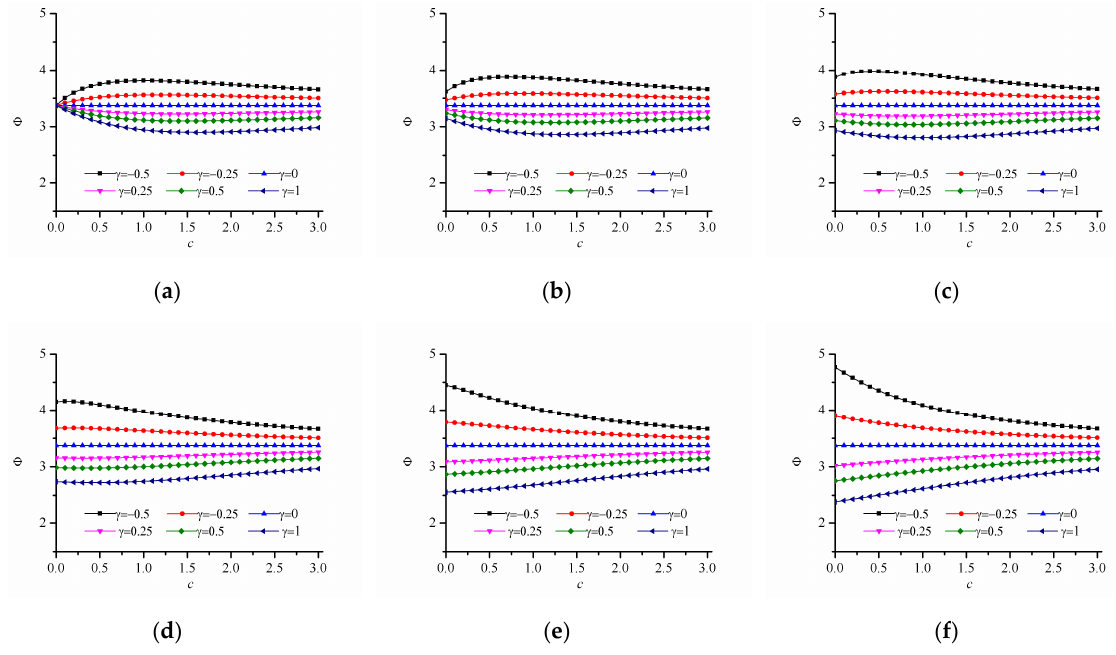
Figure 9. Variation of the failure index with different strength-modulus exponent ratio for the